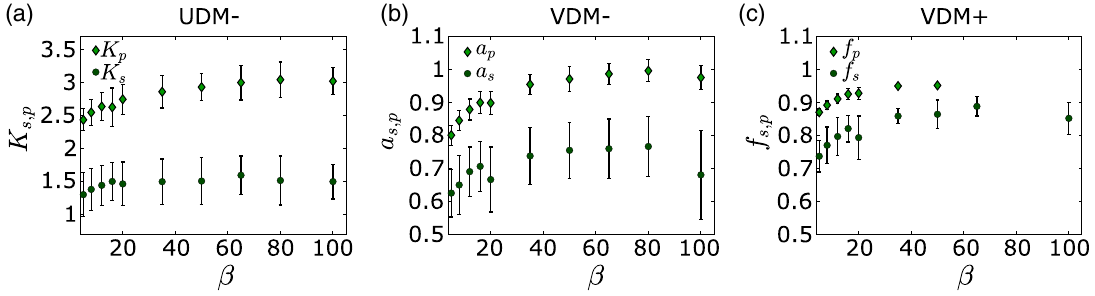
FIG. 11. Behavior of the critical parameters describing the location of the transitions (Figs. 3 and 10) as a function of the burst size β . (a) Critical values K s and K p in the UDM − . (b) Critical values a s and a p in the VDM − calculated from transition locations at K ¼ 2 . 2 , assuming the gradients of the transitions m m β , to maintain computational s and p are approximately constant when varying max ¼ 2 . 2 . For β > 50 , we do feasibility. (c) Critical values f s and f p in the VDM þ similarly calculated from transition locations at K max not observe transitions to fully pushed waves in the parameter regime of f ≤ 0 . 95 investigated. Extending the parameter regime is computationally unfeasible. In each case, to determine the error bars, we assume a 1% error in the model velocities as before, and use this to determine the resultant shift in the transition